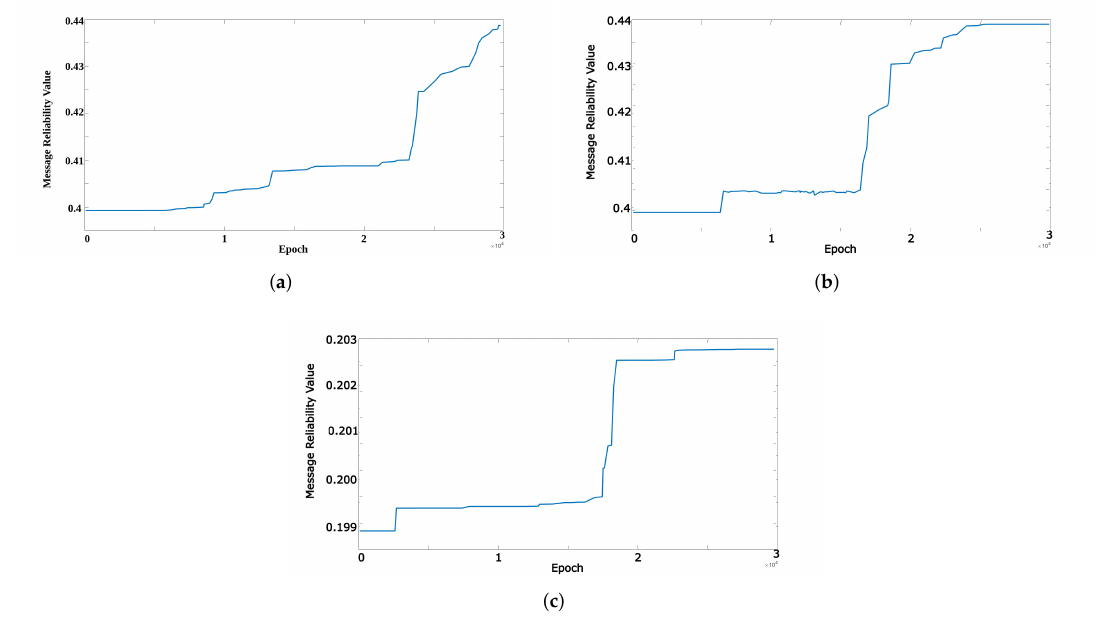
Figure 6. Changes of message reliability over time. ( a ) Event 1 (i.e., Accident); ( b ) Event 2 (i.e., Traffic); ( c ) Event 3 (i.e., Road